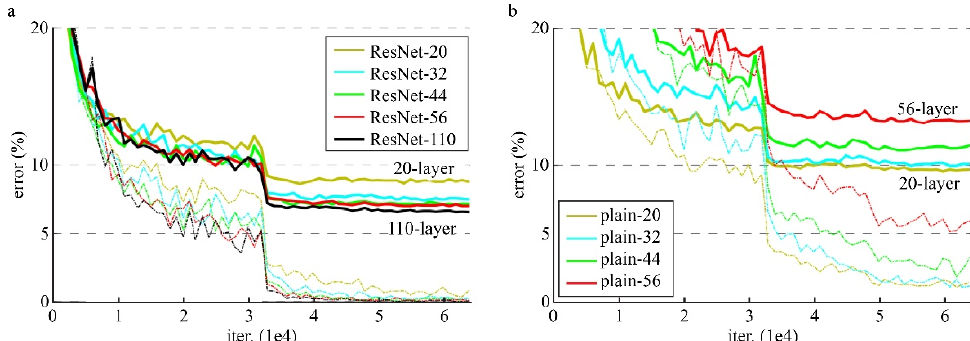
Figure 5. Training on CIFAR-10. Dashed lines denote training error and bold lines denote testing error. ( a ): ResNets. ( b ): plain networks (source: [18]).